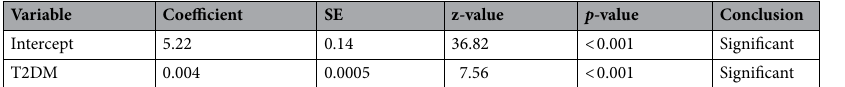
Table 4. The ANOVA of Poisson regression model. Residual deviance: 1772.8 on 22 degrees of